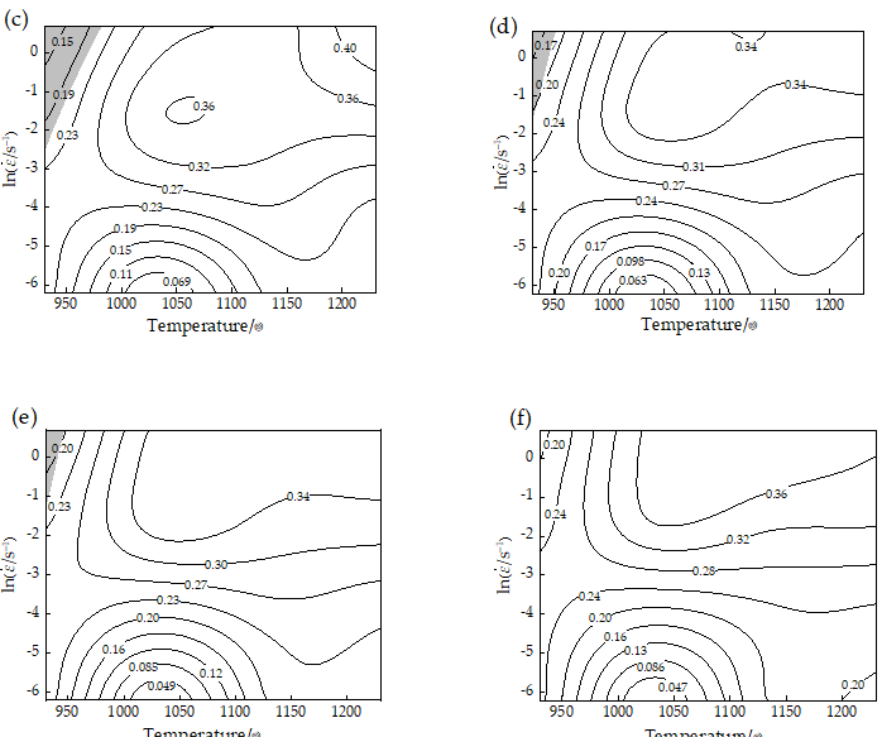
Figure 10. Processing maps for the 20MnCr5(SH) gear steel at strains of ( a ) 0.1; ( b ) 0.2; ( c ) 0.3; ( d ) 0.4; ( e ) 0.5; ( f ) 0.6.